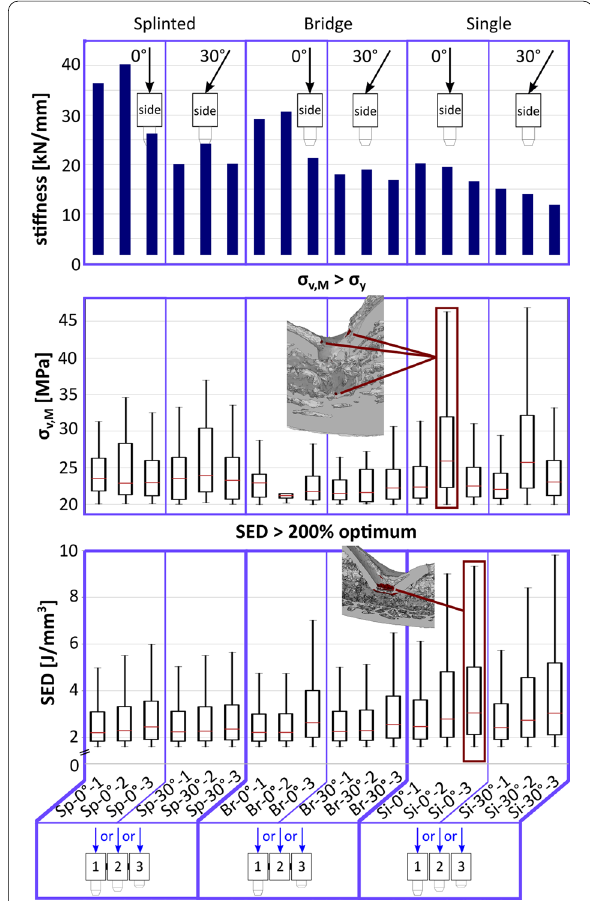
Fig. 3 Comparative FE-stiffness, von Mises stress (> yield stress) and SED (> 200% optimum) of different configurations. It is observed that the stiffness values vary depending on the type of prosthetic design and the load direction in each applied position. Note: Boxplots are shown without outliers, for easier comparison across groups. Only values above the yield limit or 200% of the optimum SED are displayed, to demonstrate the fraction of overloaded regions only, corresponding to dark red regions in Figs. 5 and 6. Insets demonstrate bone regions with values above the yield limit or 200% of the optimum SED labelled in dark red for a selected